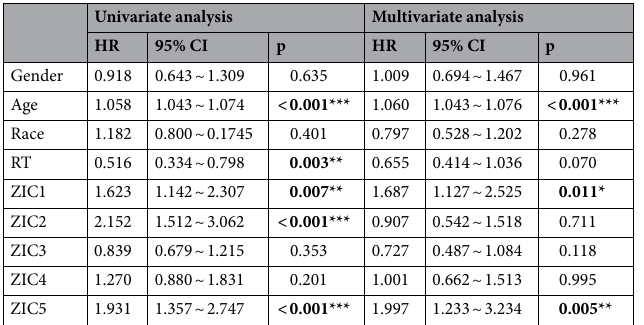
Table 1. Univariate and multivariate analysis analysis of overall survival in LGG patients. (TCGA database). RT Radiation therapy, HR hazard ration, 95% CI 95% confidential interval. * p < 0.05, ** p < 0.01, *** p < 0.001. Bold values indicate clinical significance.